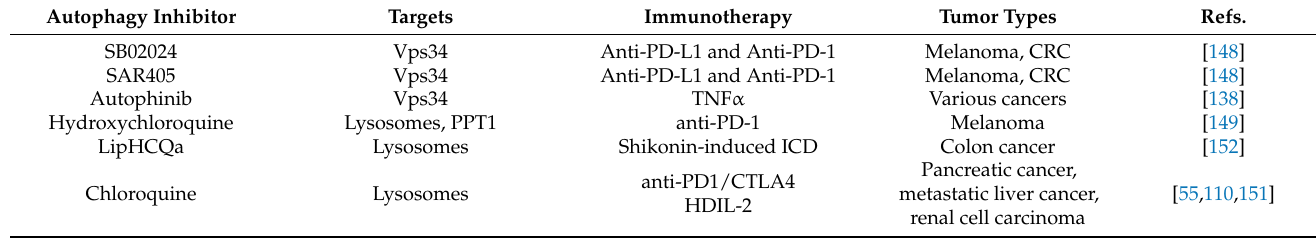
Table 1. Autophagy inhibitors enhance the efficacy of immunotherapy.